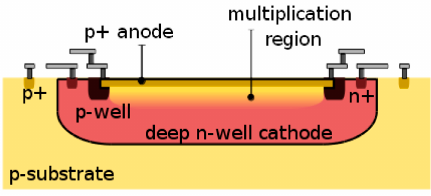
Figure 1. Planar single-photon avalanche diode (SPAD): the p+-n-well junction is biased above breakdown so as to achieve infinite optical gain. A guard ring prevents premature edge breakdown by reducing the electric field in areas at risk, such as the corners of the junction. The deep n-well acts as an insulation mechanism to minimize electrical crosstalk, while optical crosstalk is generally reduced using deep trench isolation (not available in this CMOS technology).